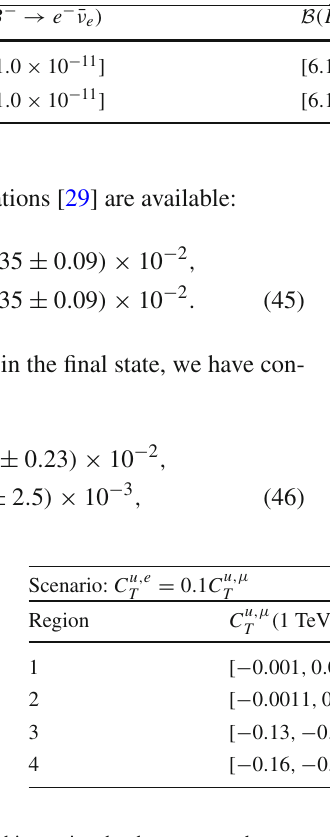
Table 6 Allowed ranges for branching ratios that have not yet been measured corresponding to the allowed ranges for | V ub | and C u the scenario where C u , e